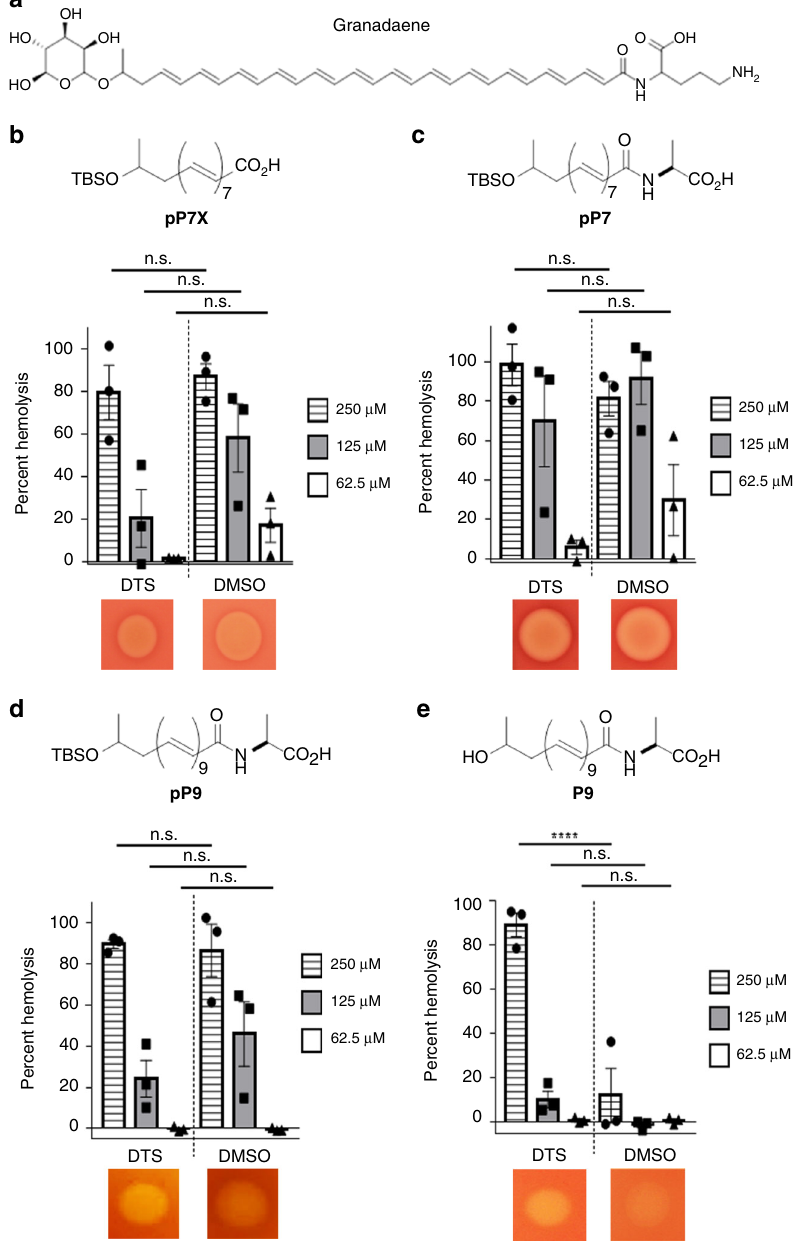
Fig. 1 The polyene chain length is important for hemolytic activity. a Granadaene contains a terminal rhamnose, a polyene chain consisting of 12 double bonds, and a terminal ornithine. b – e Synthetic analogs of granadaene (structures shown) were resuspended in DTS (DMSO + tri fl uoroacetic acid (TFA, 0.1%) + starch (20%)) or DMSO. The analogs were co-incubated with human red blood cells at 250, 125, and 62.5 µ M for 1 h at 37 °C, and